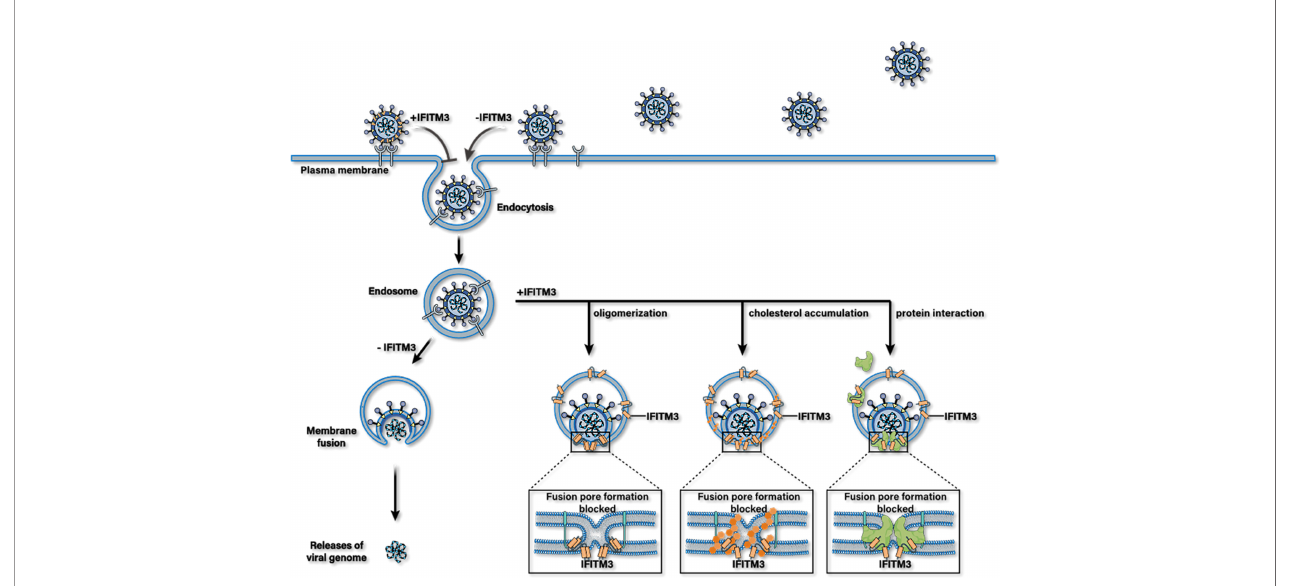
FIGURE 2 | Possible antiviral mechanisms of IFITM3. IFITM3 may inhibit the release of viral protein and nucleic acid into the cytoplasm by blocking the formation of fusion pores following virus-endosome hemifusion and before forming of an enlarged fusion pore. Whereafter, it accelerates the traf fi cking of incoming viral particles to lysosomes for destruction. IFITM3 can bind itself to multiple host proteins, interact with cholesterol, or packages into virions to reduce their infectious